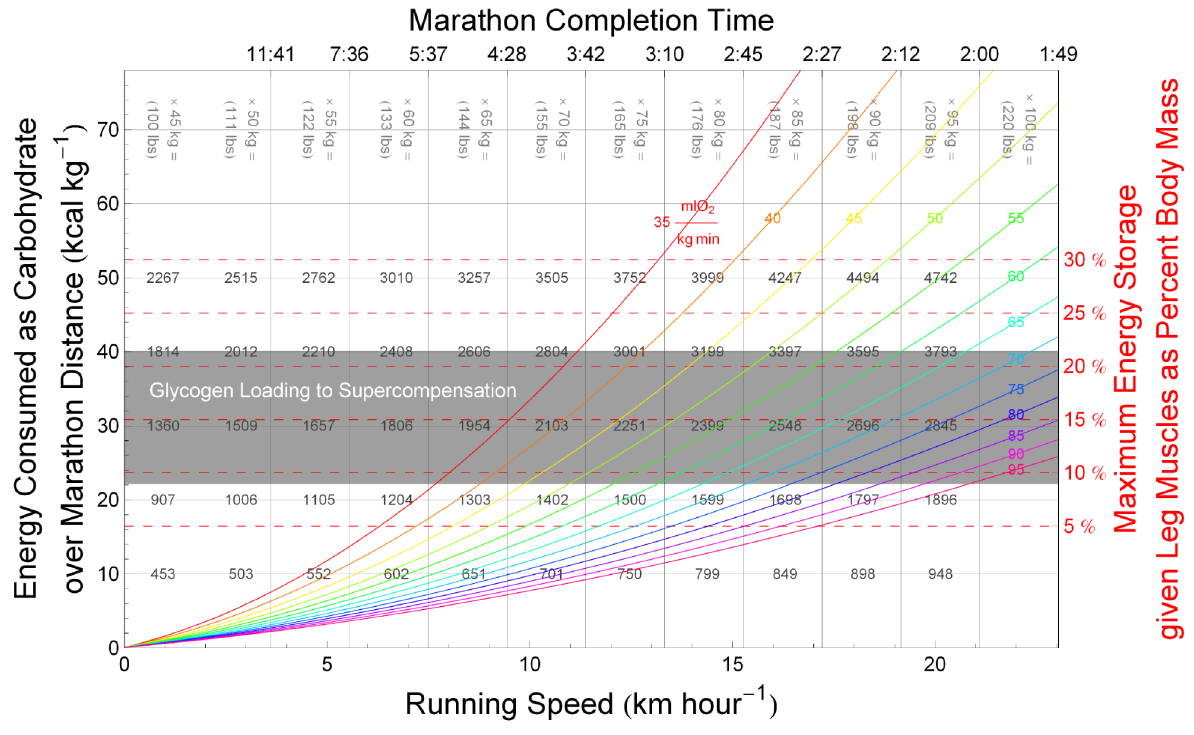
Figure 2. When does glycogen storage capacity constrain maximal marathon speed? Computed approximations of total energy consumed as carbohydrate over the course of a marathon, as a function of running speed, in runners with various aerobic capacities. Each colored line corresponds to a particular value of aerobic capacity, _ VVO 2 max , in terms of milliliters of oxygen per kilogram body mass per minute, as labeled (Dark Orange, 35; Orange, 40; Yellow, 45; Light Yellow, 50; Light Green, 55; Green, 60; Aqua, 65; Light Blue, 70; Blue,75; Purple, 80; Violet, 85; Magenta, 90; Red, 95mLO 2 kg { 1 min { 1 ). The vertical scale is expressed in terms of kilocalories of energy consumed per kilogram of body mass over 42.195 km (26 miles and 385 yards), the length of a marathon; the corresponding total energy consumption for runners of various masses is shown along the horizontal trend lines, beneath the values of body mass labeled along the top edge of the plot. Running speed is expressed in kilometers per hour along the lower horizontal axis, and as total time to complete a marathon at the corresponding speed along the upper horizontal axis. The dashed, horizontal red lines show the estimated maximum energy storage capacity in runners with maximally glycogen-loaded livers and glycogen-loaded muscles in a state of maximal glycogen supercompensation (144 kcal glycogen per kilogram leg muscle), for whom the leg muscles powering running constitute the indicated percentages of total body mass (right-sided vertical axis). The shaded region indicates the range of supranormal energy storage capacities available to a typical male runner, whose leg muscles constitute approximately 21.4% of his total body mass; the boundaries of the shaded region correspond to typical and maximal values of muscle glycogen density for trained endurance athletes (80 and 144 kcal glycogen per kilogram leg muscle, respectively). See the text for a detailed explanation.